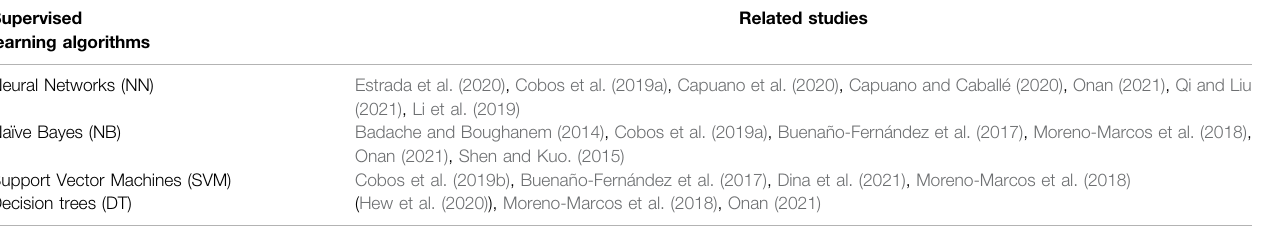
TABLE 4 | Most frequently used supervised learning algorithms.